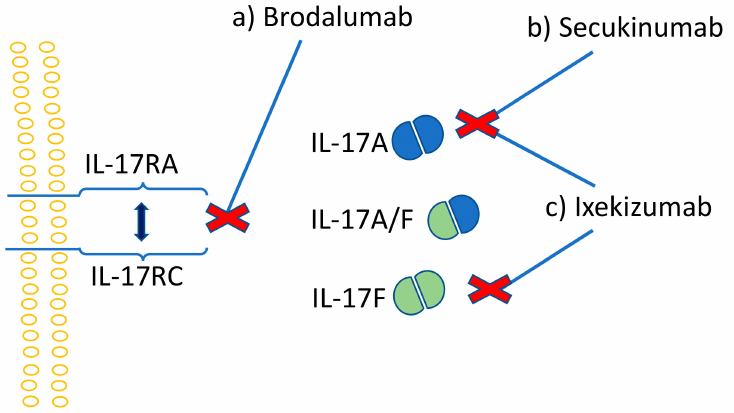
Figure 4. IL-17 cytokine inhibitors; ( a ) brodalumab, with a ffi nity to IL-17RA / RC receptor complex, ( b ) secukinumab, with a ffi nity to IL-17A, and ( c ) ixekizumab, with a ffi nity to both IL-17A and IL-17F, interrupt the intracellular signaling by inhibiting the interaction between IL-17 and its